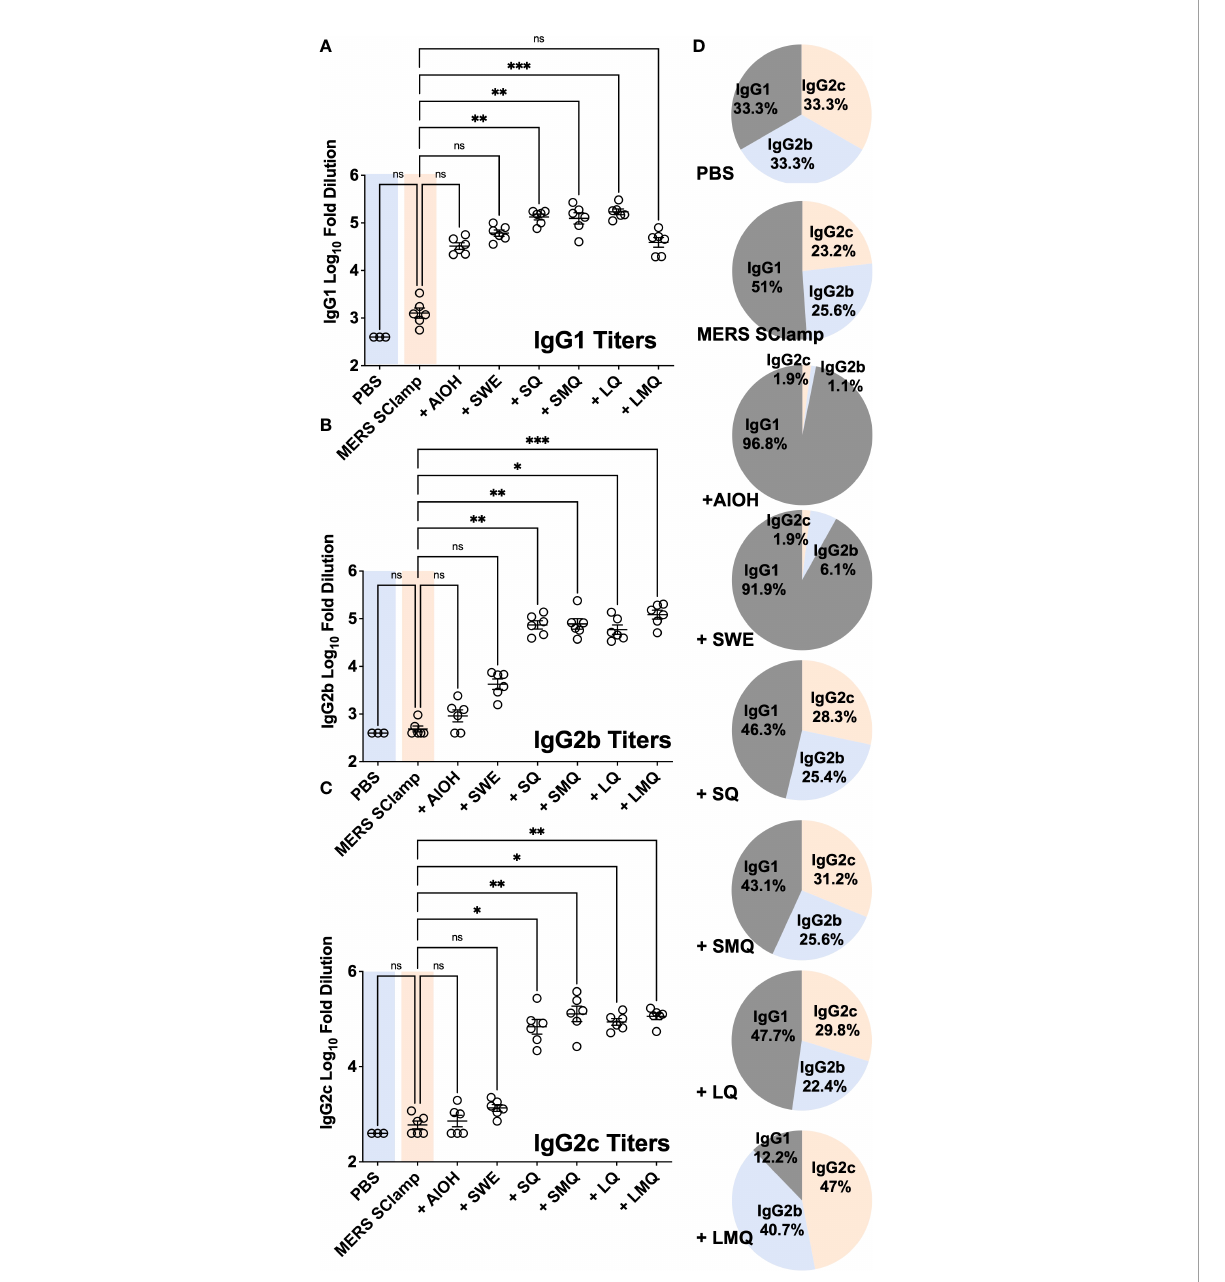
FIGURE 2 Tested adjuvants elicit different antibody isotypes. Mouse serum from the same experiment as Figure 1A was assessed for antibody isotype by ELISA with secondary antibodies speci fi c for mouse IgG1 (A) , IgG2b (B) , IgG2c (C) , and (D) proportion summaries of IgG isotypes induced by each adjuvant. Individual data points presented with mean +/- SEM. Kruskal-Wallis with Dunn ’ s test, ns = P>0.05, *P<0.05, **P<0.01, and ***P<0.001. Experiment completed once, n = 3 – 6